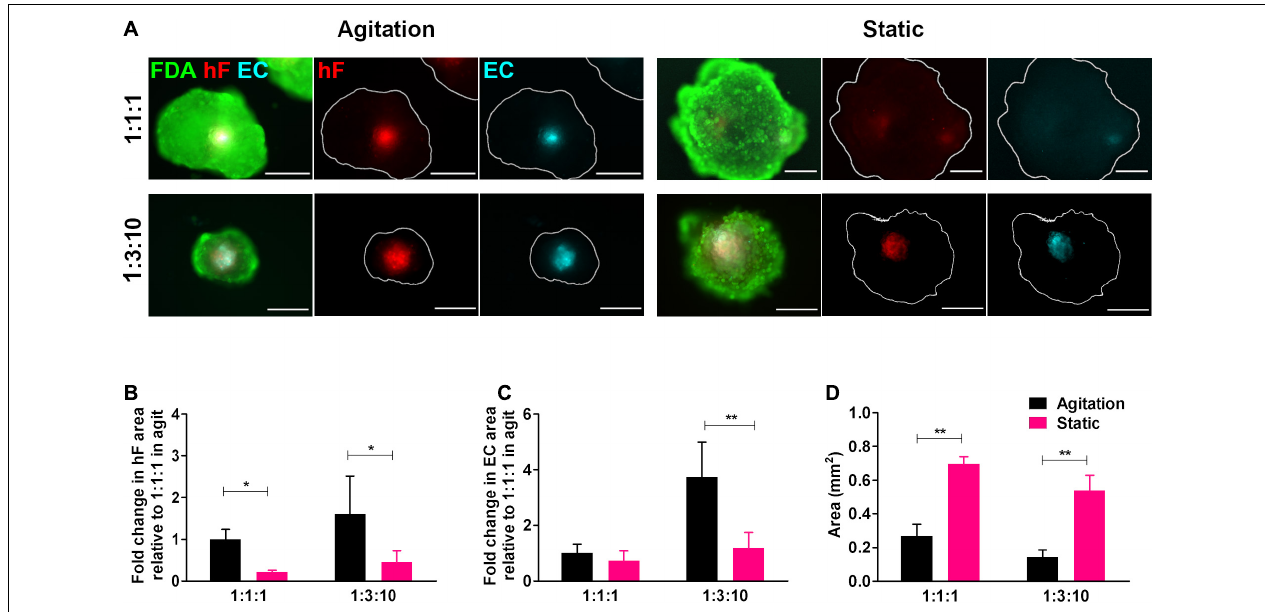
FIGURE 3 | Cell viability and endothelial cell content in triple heterotypic spheroids: effect of agitation. (A) Fluorescence microscopy of triple heterotypic spheroids at day 30 of culture in agitation (2 days of static culture followed by 28 days of agitation-based culture, rotational speed of 100 rpm) or in static (30 days of static culture) conditions. Spheroids generated by seeding 6,000 cells per well, at distinct ratios of HCC1954 breast tumor cells (TC); human dermal fibroblasts, labeled with PKH26 (hF, red); and HUVEC, labeled with CellTracker Deep Red (EC, cyan). Live cells were stained with FDA (green). Images are representative of the 5–10 spheroids assessed per condition, in each of the three to four independent experiments performed. Scale bar, 250 µ m. Quantification of (B) fold change in hF area, (C) fold change in EC area, and (D) total spheroid area at the equatorial axis, for spheroids from A. The EC and hF areas were normalized for the total spheroid area at the equatorial axis; the fold change was determined relative to the condition with a TC:hF:EC of 1:1:1, agitation. Data are presented as mean ± SD from N = 3–4 (independent experiments); in each experiment, at least 20 spheroids were quantified per condition. Statistical analysis was performed using unpaired t -test two-tailed comparing agitation to static for each cell ratio; in B, * p = 0.015 for 1:1:1 and * p = 0.047 for 1:3:10; in C, ** p = 0.0068 for 1:3:10; and in D, ** p = 0.0017 for 1:1:1, ** p = 0.0014 for